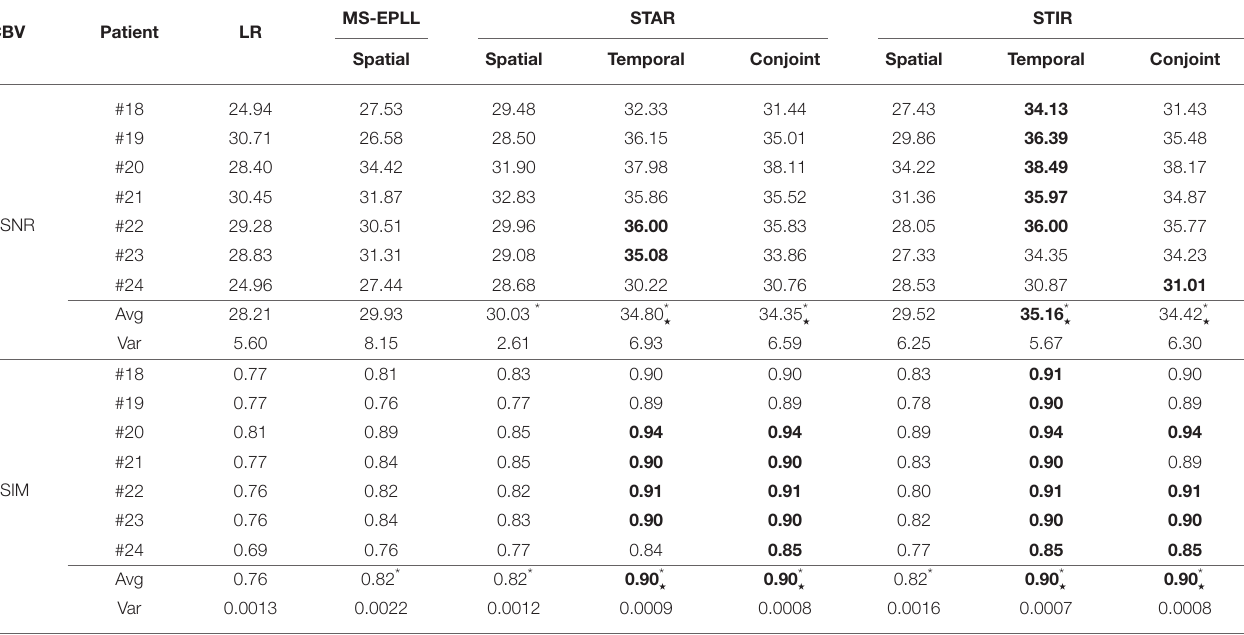
TABLE 7 | PSNR and SSIM comparison of seven patients’ CBV maps calculated at scale S 3 with tube current 40